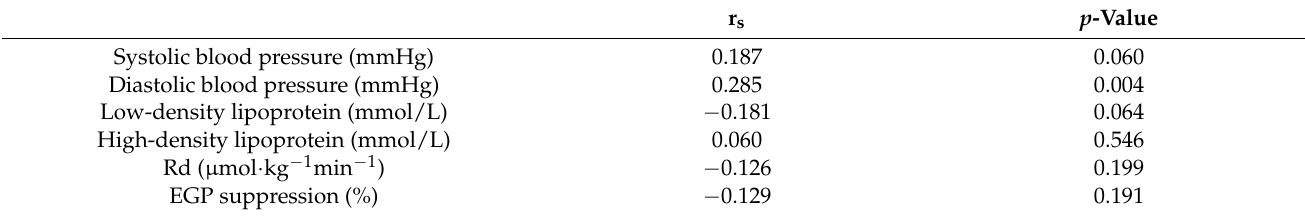
Table 2. Correlation imidazole propionate (nM) with cardiovascular risk factors and insulin resistance.